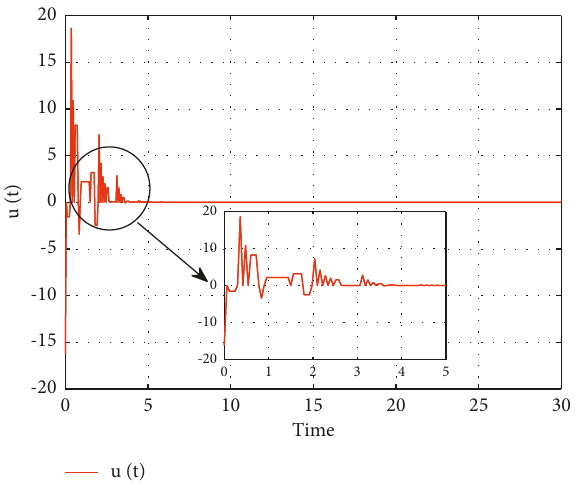
Figure 10: Control input signal u ( t ) .